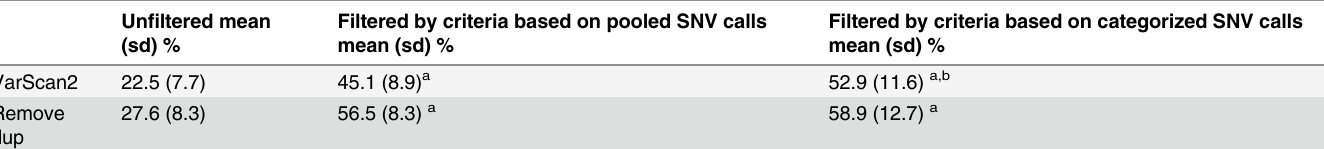
Column one (Un fi ltered) contains all SNV calls generated using default parameters except for requiring p-value less than 0.05. Column two contains SNV calls that were fi ltered based on results from pooled SNV calls as shown in Fig 2. Column three contains SNV calls that were fi ltered based on results from categorized SNV calls as shown in Fig 3. Row two (Remove dup) shows the same variables after removal of duplicated reads. a Signi fi cantly different from the concordance rates of un fi ltered SNV calls (p-value < 10 -10 ). b Signi fi cantly different from the concordance rates of fi ltered by criteria based on pooled SNV calls (p-value =